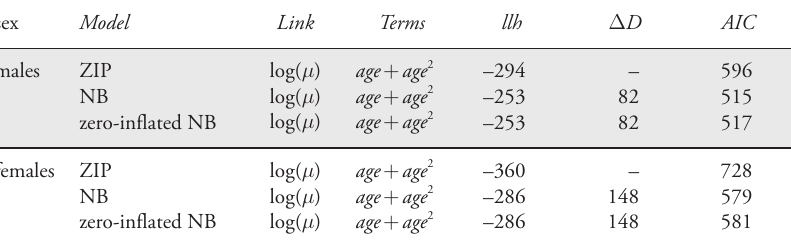
Table 3: Quality of fit statistics using